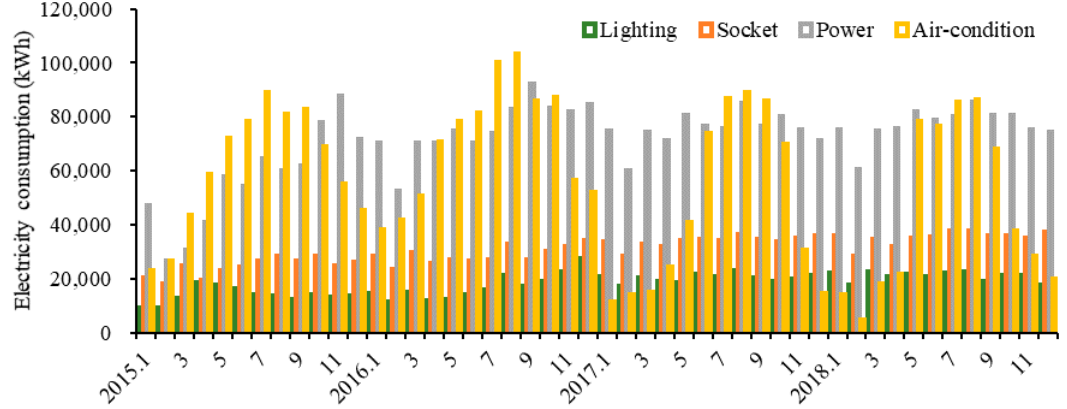
Figure 3. The electricity consumption of CTIC. Table 2. Basic information of the selected 31 rooms.